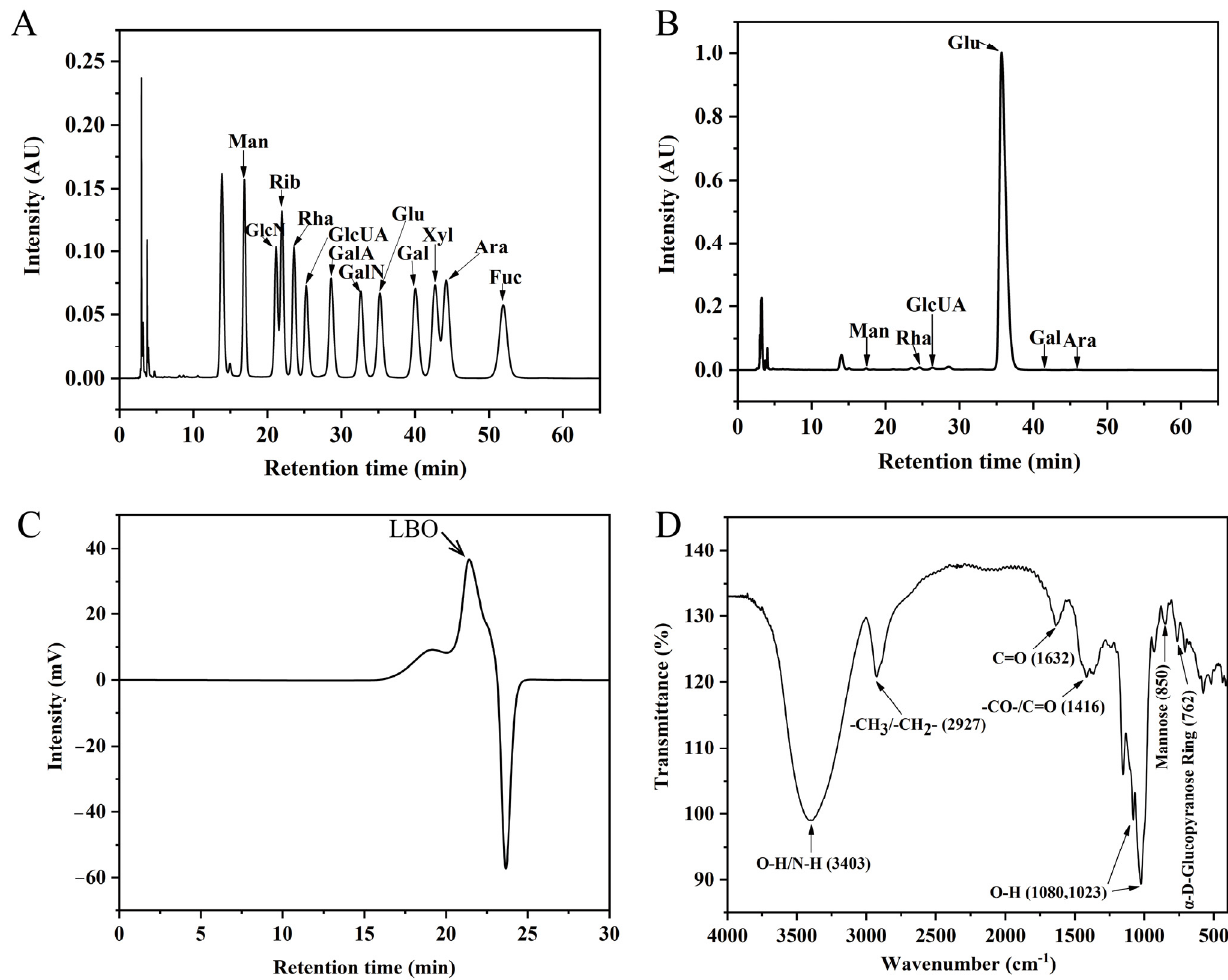
Figure 1. Chemical characterization of LBO. ( A ) IC of standard monosaccharides. ( B ) IC of LBO. ( C ) HPGPC of LBO. ( D ) FT-IR chromatogram of LBO. LBO: Lycium barbarum oligosaccharide; IC: ion chromatography; HPGPC: high performance gel permeation chromatography; FT-IR: Fourier trans-